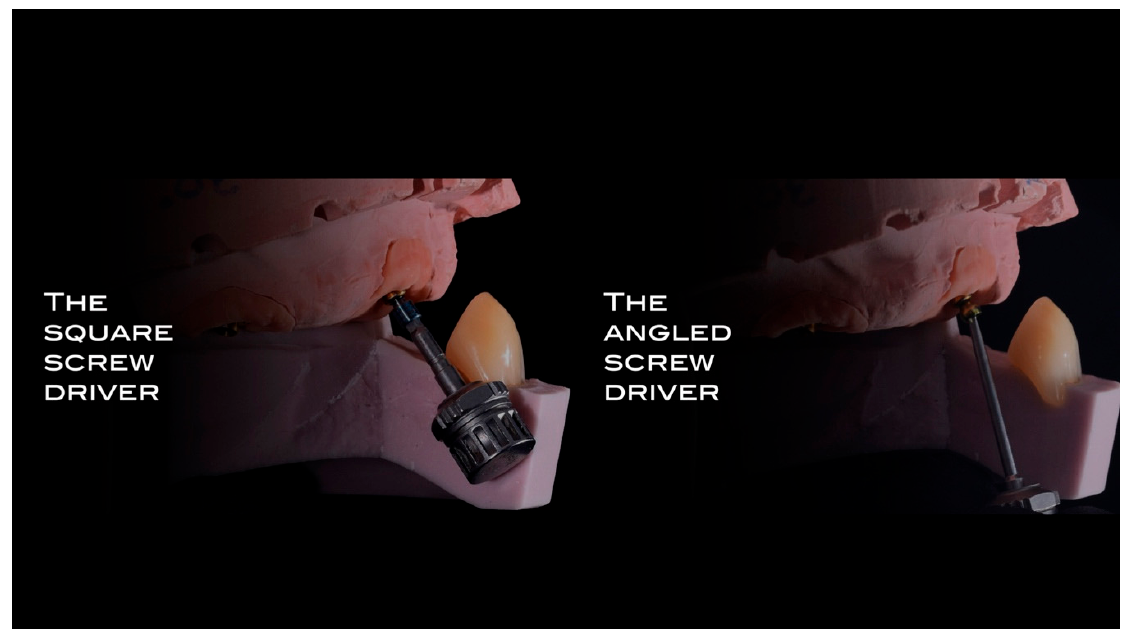
Figure 16. Difference between normal screw and the angled screwdriver’s